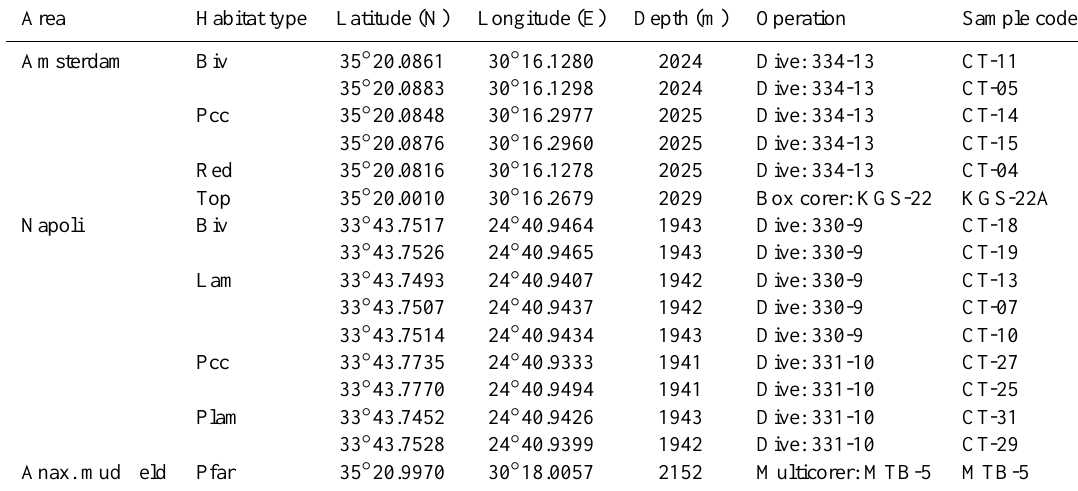
Table 1. Station information showing microhabitat type, position, depth, dive number of the ROV and sample code. Samples collected from the same type of microhabitats were treated as replicate samples (Biv: bivalve shells; Pcc: periphery of carbonate crusts; Red: reduced sediments; Top: summit of the mud volcano; Lam: Lamellibrachia microhabitat; Plam: periphery of Lamellibrachia ; Pfar: far periphery). Area Habitat type Latitude (N) Longitude (E) Depth (m) Operation Sample